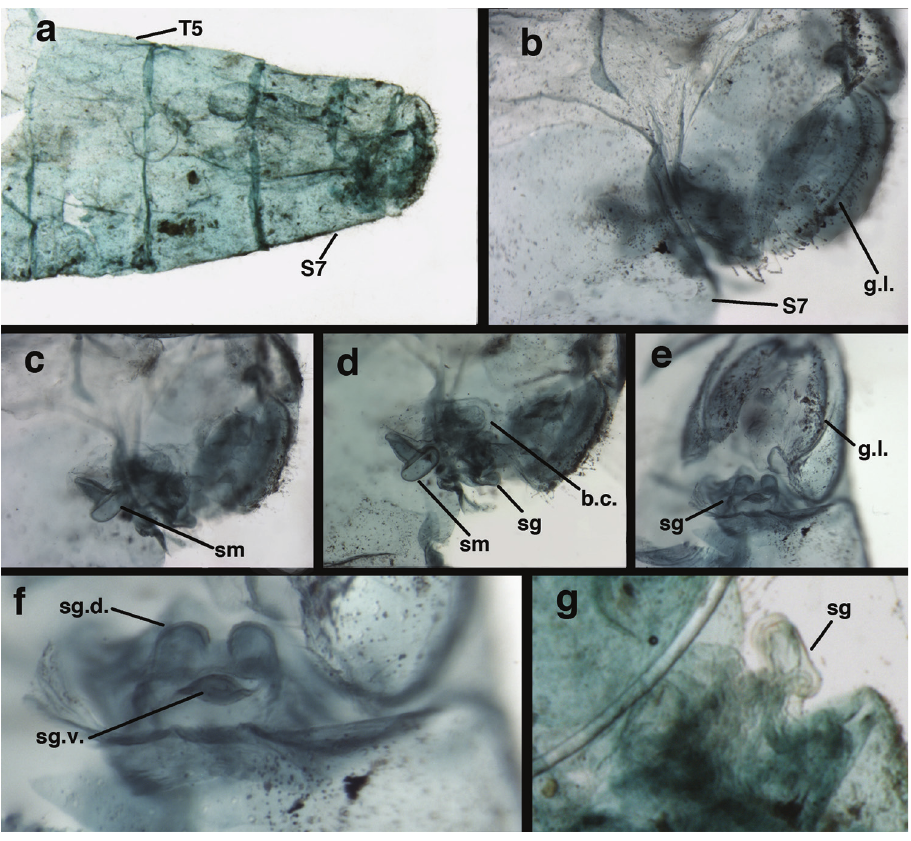
Figure 36. Chrysopa favrei Navás: Female abdomen, ( a ) segments A5-A10, lateral ( b ) terminalia, exte- rior, lateral ( c, d ) genitalia, interior, lateral ( e ) gonapophysis lateralis, subgenitale, posterior ( f ) subgeni- tale, posterior ( g ) subgenitale, lateral. b.c. bursa copulatrix g.l. gonapophysis lateralis S7 seventh sternite sg subgenitale sg.d. dorsal lobe of subgenitale sg.v . ventral lobe of subgenitale sm spermatheca T5 fifth tergite (all: Colombia, Valle de Quindio, lectotype, MNHN).